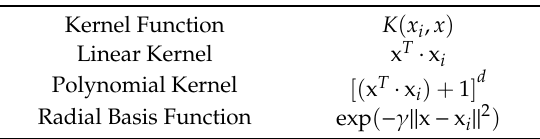
Table 2. Common kernel function.